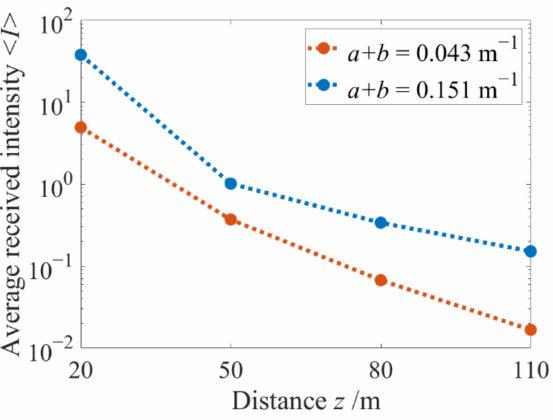
Figure 10. Average received light intensity versus the transmission distance with different absorption and scattering coefficients.